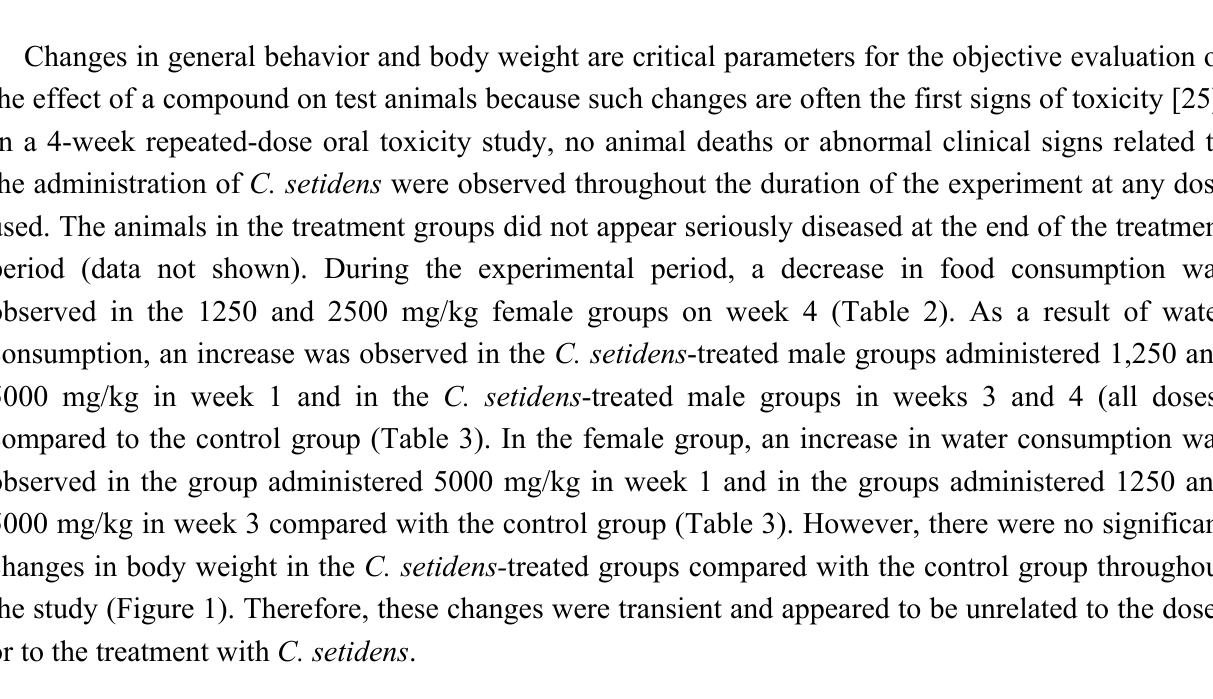
No Gross Mortality Signs Finding (Dead/Total) Day